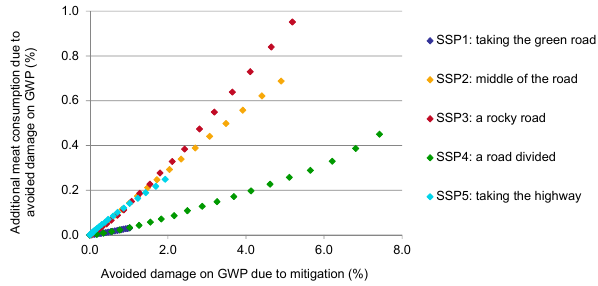
Figure 5. Impact of avoided damage to GWP (% of total GWP) due to mitigation on global aggregated meat consumption in 2100 relative to 2000 for the five